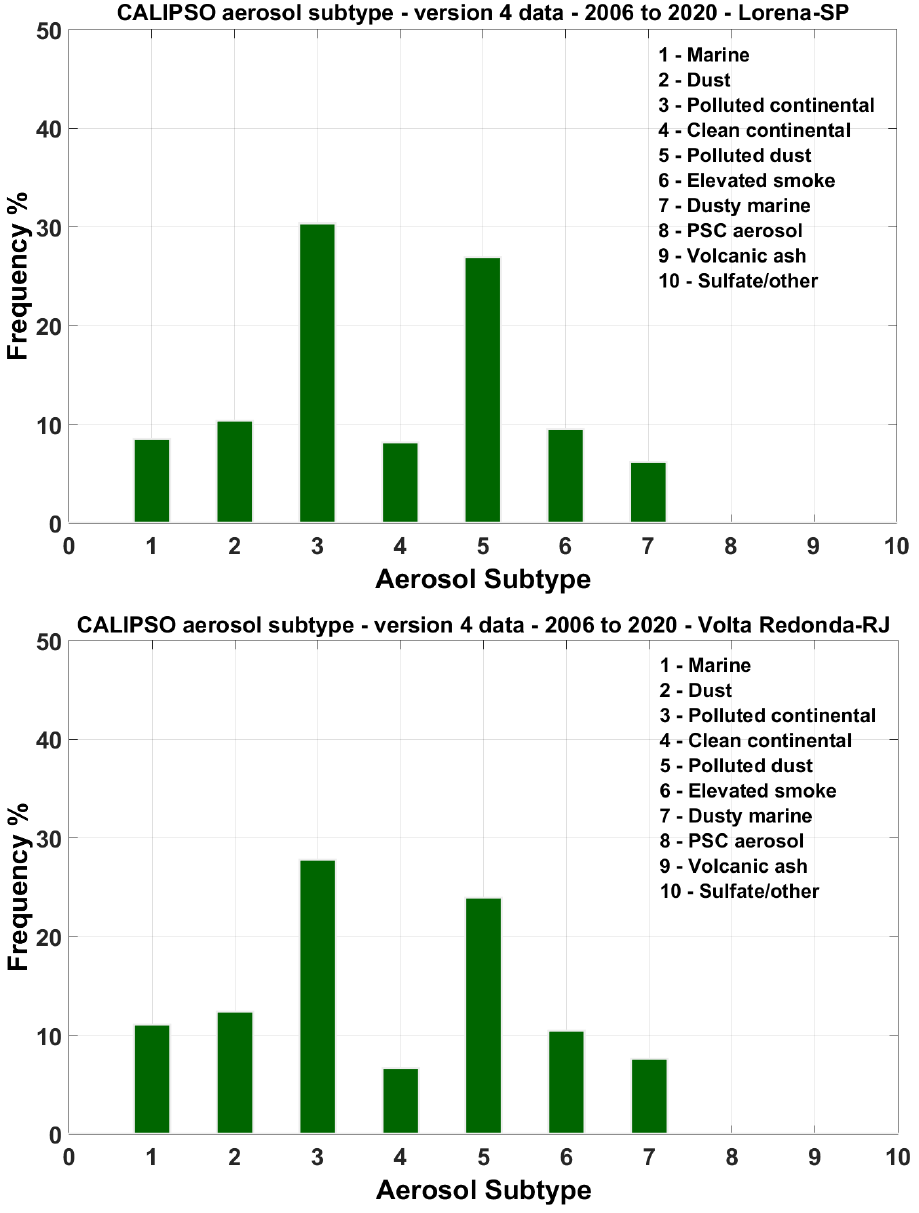
Figure 5. Frequency of occurrence of aerosol subtype flagged by CALIOP/CALIPSO data over Lorena-SP and Volta Redonda-RJ for the period of June of 2006 to December of 2020. The MSP-LIDAR II system was the only single remote sensing instrument employed during the measurement campaigns in Volta Redonda and Lorena. In both locations there is no structure for atmospheric monitoring, such as weather stations,